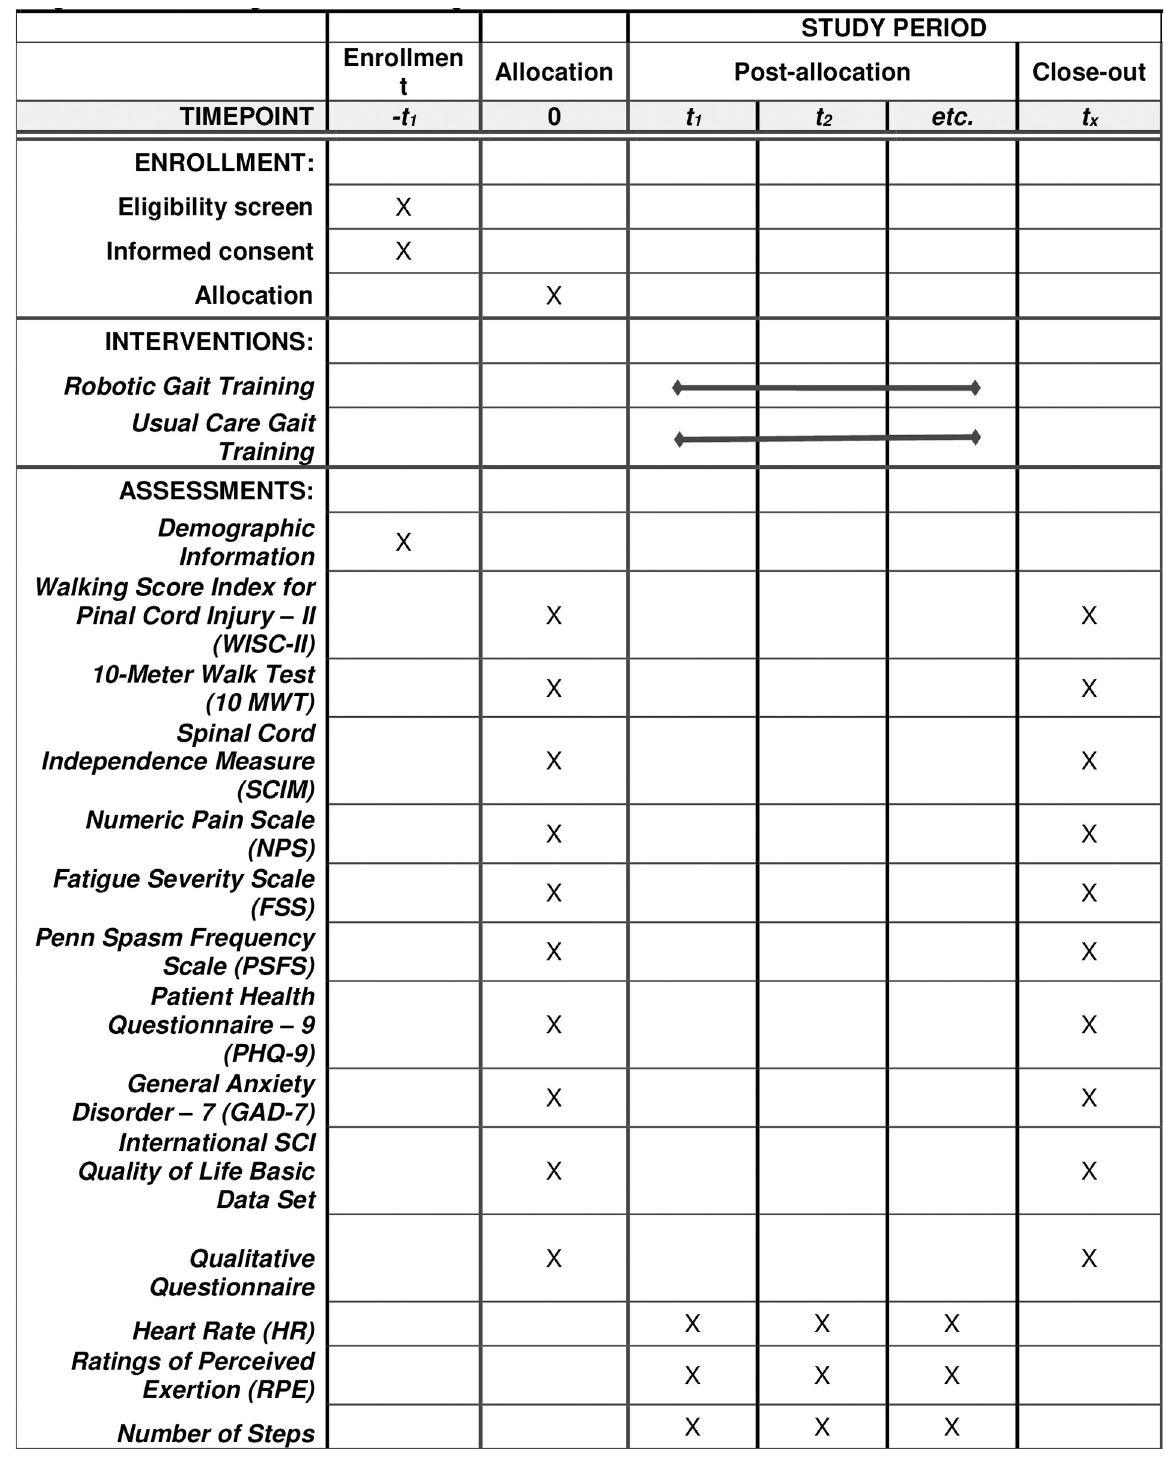
Fig 1. SPIRIT figure summarizing patient event timeline.